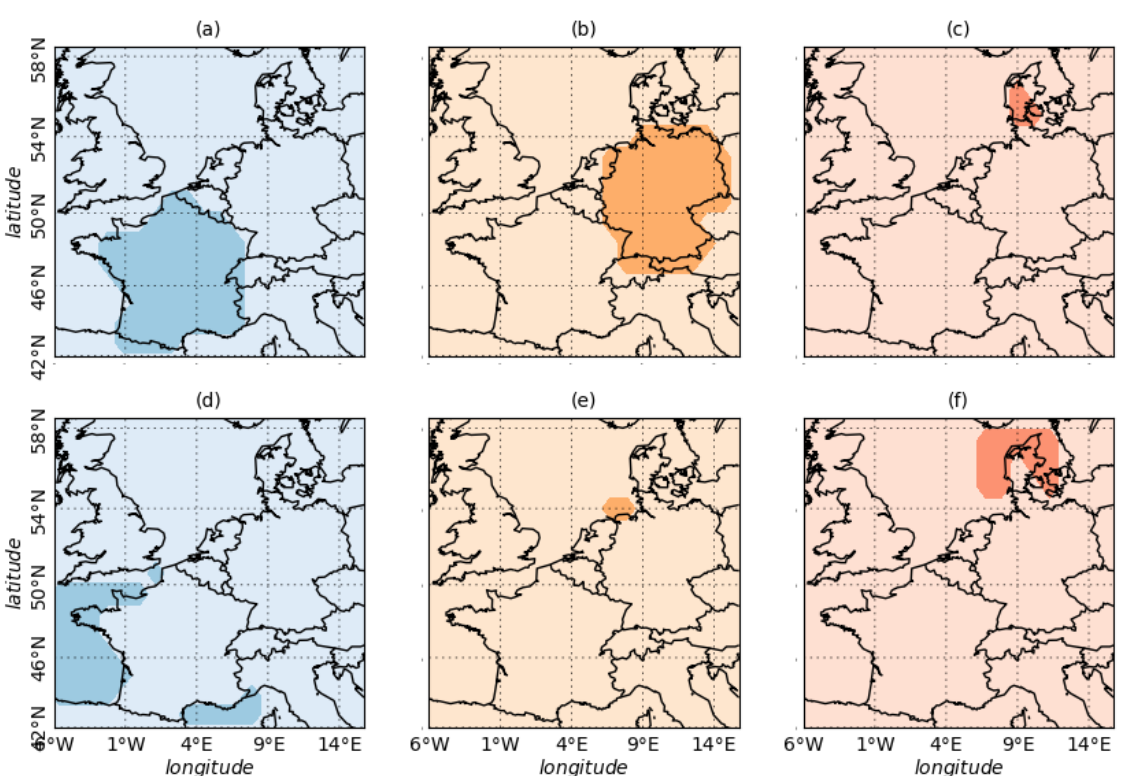
Figure A1. Domains and onshore and offshore masks in ERA20C data. Note: onshore (figures ( a – c )) and offshore (figures ( d – f )) masks are drawn for each country to highlight the difference between onshore wind farms which have a lower capacity factor and lower costs and offshore wind